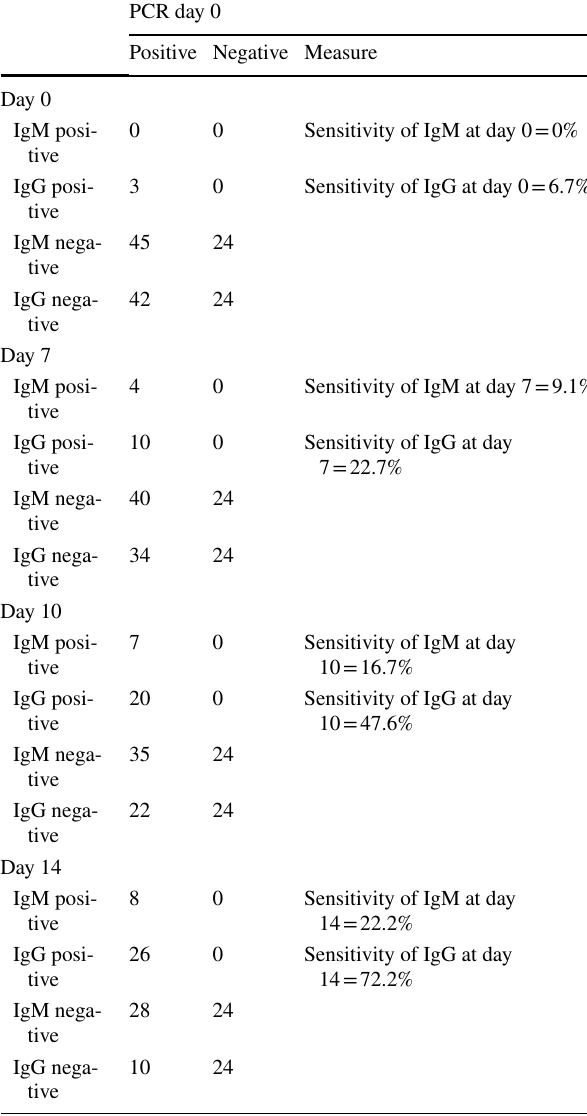
Table 2 The sensitivities of the IgM and IgG assays compared with the gold standard method